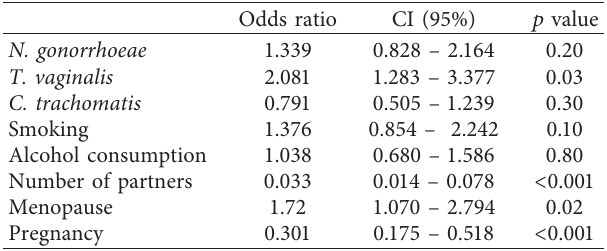
Table 3: Binary logistic regression to verify possible predictors of cytological lesions.